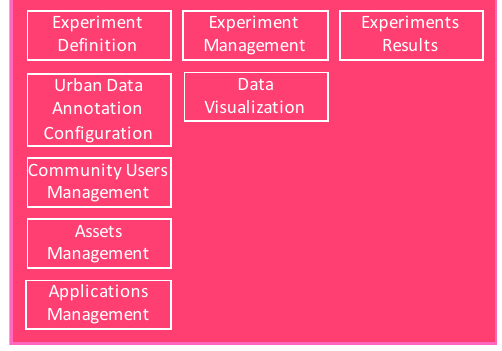
Figure 4. Experimentation Management framework.